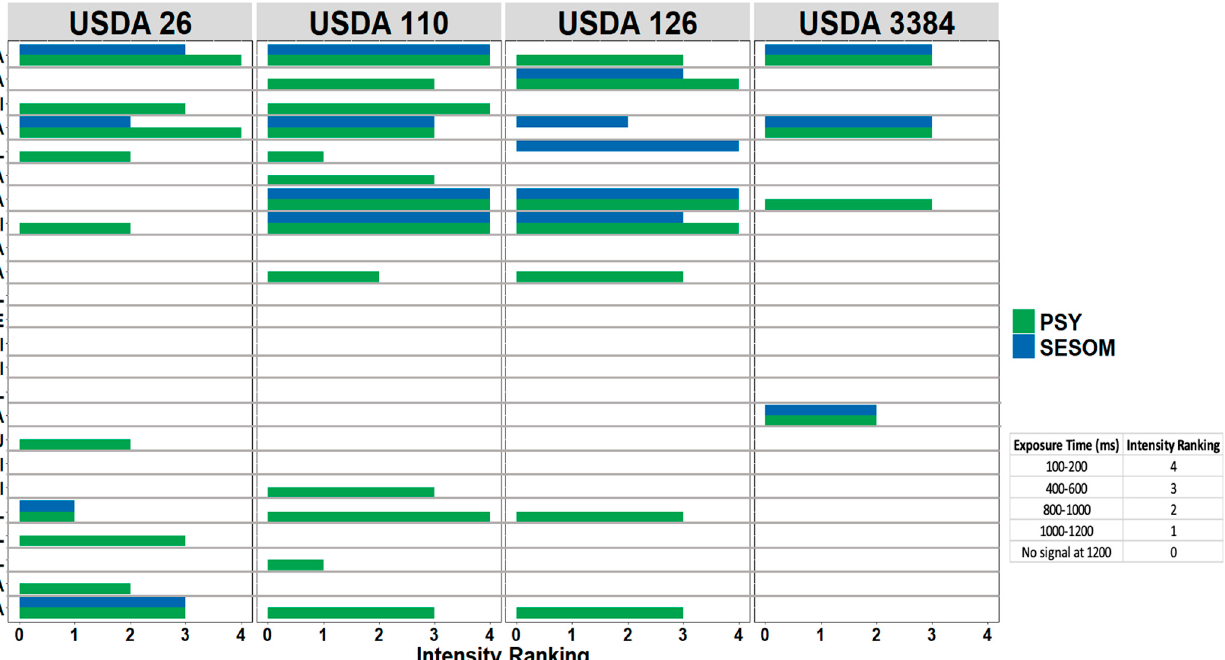
Figure 2. Motility radius of Bradyrhizobium strains spot-inoculated into either PSY-Arabinose or SESOM solidified with 0.35% agar and incubated for 10 d. Data were analyzed by Student t -test, and p values indicate statistical significance (ns not significant, ** p < 0.01, **** p < 0.0001).